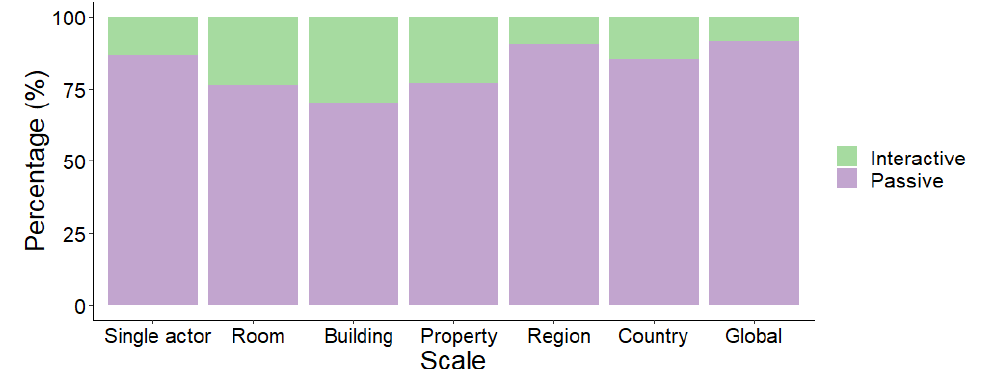
Figure 29. Deployment distribution between deployment scale and